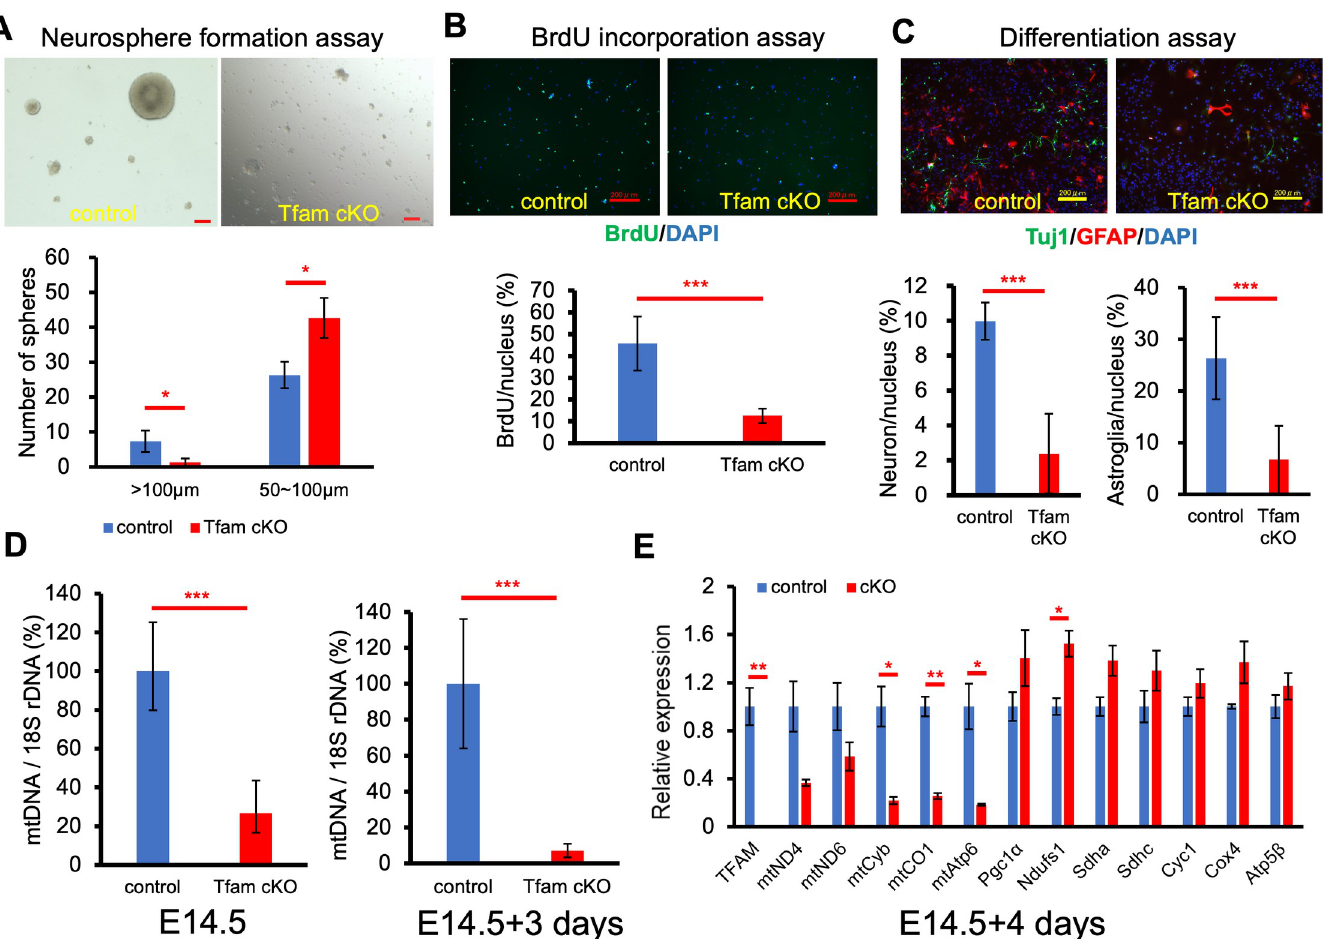
Fig 2. Neurosphere analysis. (A) Neurosphere formation assay. Representative images are shown. The number and the size of the spheres were measured, and the distribution of sphere number based on sphere size is shown. At least three independent clones per genotype were measured. Scale bars, 100 μ m. Graph shows means ± SD. � P < 0.05. (B) BrdU incorporation assay. Cultured NSCs were incubated with 10 μ M BrdU for 2 h and incorporated BrdU was detected using an anti-BrdU antibody. BrdU positive cells were counted. Graph shows means ± SD. ��� P < 0.001. At least two independent clones per genotype were measured. Scale bars, 200 μ m. (C) Differentiation of NSCs. NSCs on coverslips were cultured in differentiation medium for 7 days. Neurons and astroglia were detected by immunostaining with anti- Tuj1 and anti-GFAP antibodies, respectively. DAPI was used for nuclear staining. Graph shows means ± SD. ��� P < 0.001. At least three independent clones per genotype were measured. Scale bars, 200 μ m. (D) The relative mtDNA copy number analysis. The amount of mtDNA was measured by qRT-PCR using the 18S rRNA gene for normalization. Graph shows the control as 100%. DNA in the left panel was isolated from cortex cells at E14.5 and DNA in the right panel were isolated from 3-day cultured neurospheres. Graph shows means ± SD. n = 3 per group. ��� P < 0.001. (E) Relative expression analysis of mtDNA- and nDNA-encoded OXPHOS genes. The expression levels of each gene were normalized with the expression levels of β -actin. Graph shows means ± SD. n = 3 per group. � P < 0.05; �� P < 0.01.